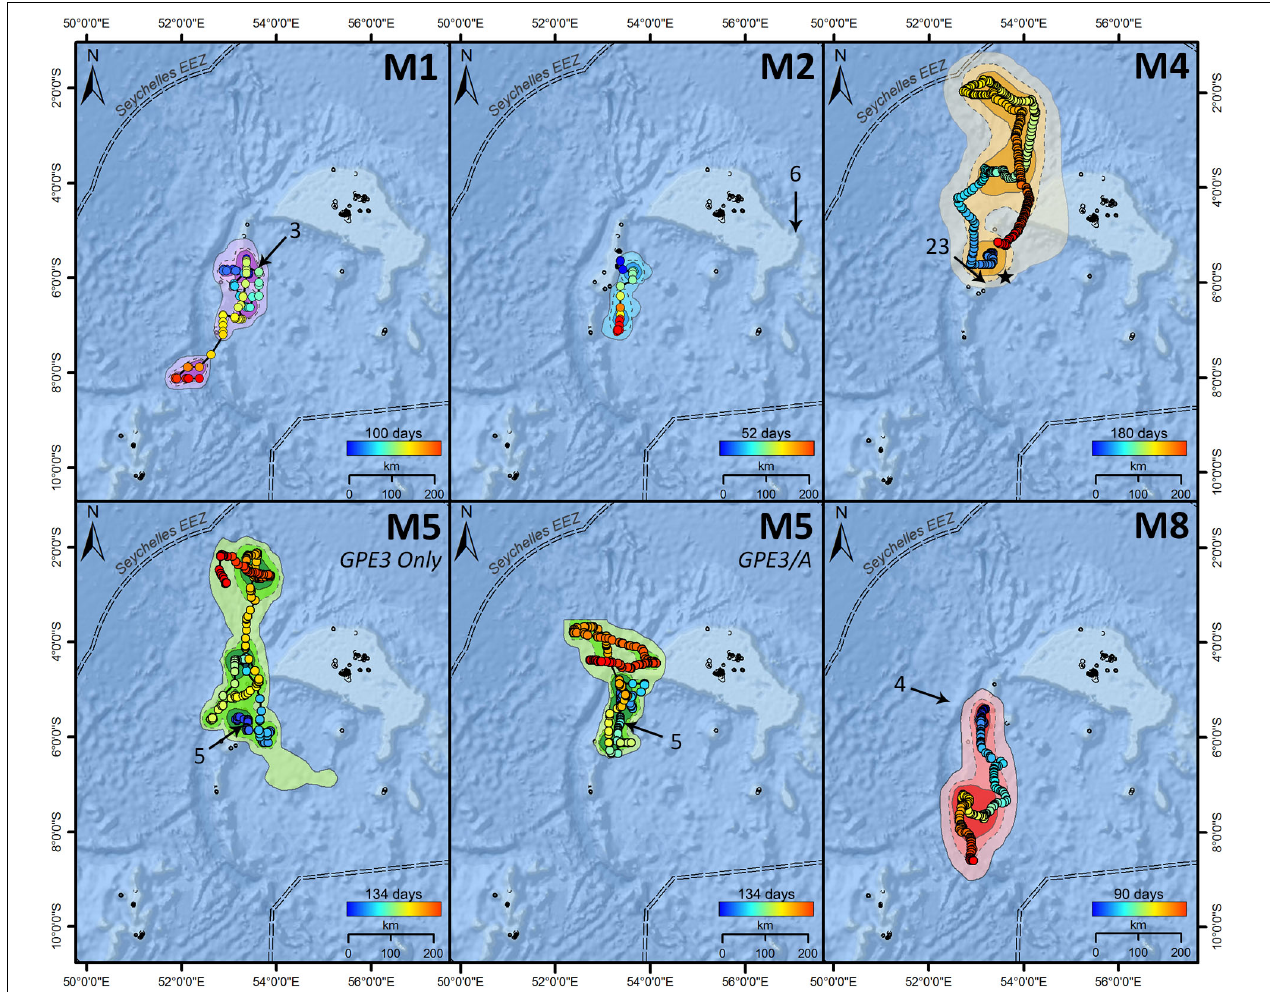
FIGURE 3 | Most-probable tracks for reef manta rays ( Mobula alfredi ) M1, M2, M4, M5, and M8 tagged with archival pop-up satellite tags (miniPATs) at D’Arros Island, Seychelles. For M5, the “GPE3 Only” track was estimated only from archived light, depth, and temperature data, whereas the “GPE3/A” track included an additional 481 acoustic detections from a passive receiver array. Tracks progress from blue to red, with track duration presented above color bars. Arrows indicate the first Argos location of each transmitting tag, and the associated numbers show the number of days that the tag was estimated to have been drifting at the surface prior to transmissions beginning. Home range represented by dark (core area; 50% NUD), medium (75% NUD), and light (extent of area; 95% NUD) color shading, where NUD represents the normalized utilization distribution for the individual. “ (cid:70) ” in M4 indicates the location of a re-sighting event recorded 184 days after tag